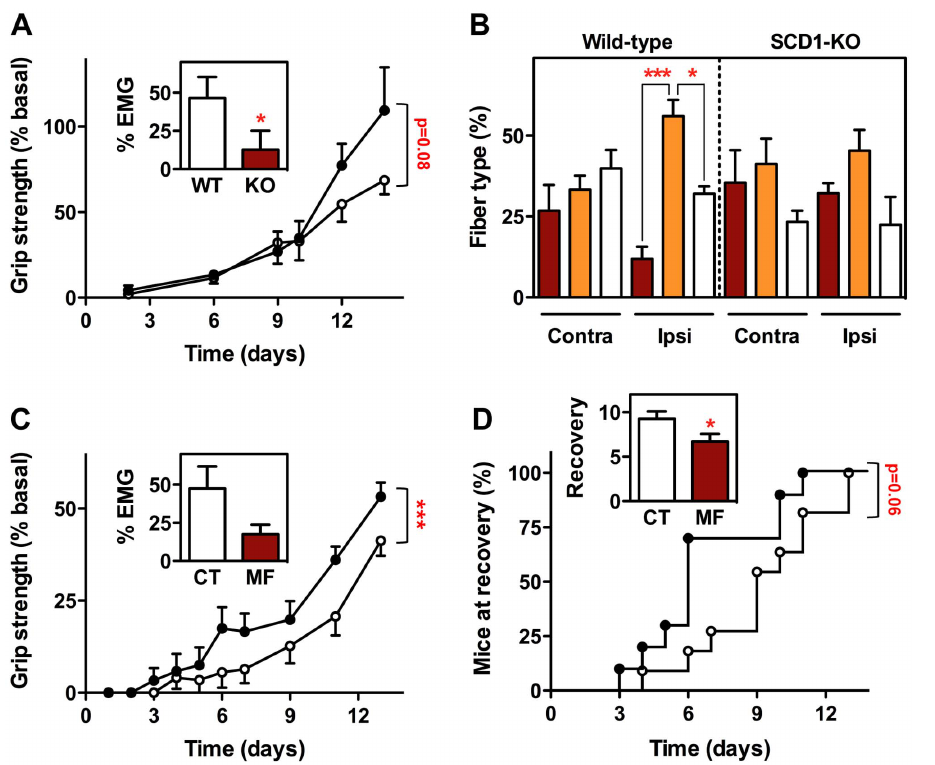
Figure 6. Muscle function recovery in SCD-deficient mice submitted to nerve crush. Restoration of muscle grip strength in SCD1 knockout mice (A) or MF-438 treated mice (C) (black circles) and corresponding control littermates (white circles) at the indicated post-operation times. *** P , 0.001 (2-way ANOVA, n=4–12). Percentage of electromyography episodes of spontaneous activity in SCD1 knockout mice (Inset A) or MF-438 treated mice (Inset C) (KO or MF, brown columns) and corresponding control littermates (WT or CT, white columns) two weeks after sciatic nerve crush. * P , 0.05 (Unpaired t-test, n=4–7). (B) Relative density of muscle fiber types in ipsilateral and contralateral tibialis anterior from SCD1 knockout mice and wild-type littermates two weeks after sciatic nerve crush. According to SDH histochemistry, fibers were classified as dark brown colored fibers with high metabolic oxidative capacity (brown columns), pale brown colored fibers with medium oxidative capacity (orange columns) and non- satined fibers (white columns). * P , 0.05 and *** P , 0.001 (1-way ANOVA followed by Tukey’s multiple comparison test, (n=4–6). (D) Kaplan-Meier curves showing the percentage of MF-438 treated mice (black circles) and control littermates (white circles) that started to exhibit a grip strength distinct from zero after initial total paralysis. Logrank test (n=10–11). Inset D, averaged time at start of recovery in MF-438 treated mice (MF, brown column) and control littermates (CT, white column). * P , 0.05 (Unpaired t-test, n=10–11).